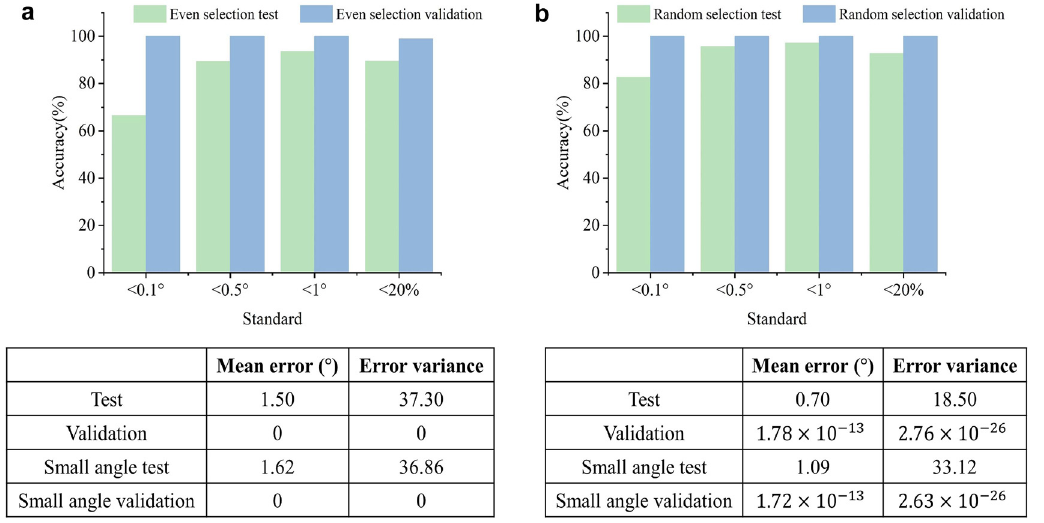
Figure 5: RF training results.The proportion of testing samplesinError abs ≤ 0 . 1 ° , Error abs ≤ 0 . 5 ° , Error abs ≤ 1 ° , and Error small ≤ 20% are shownin the